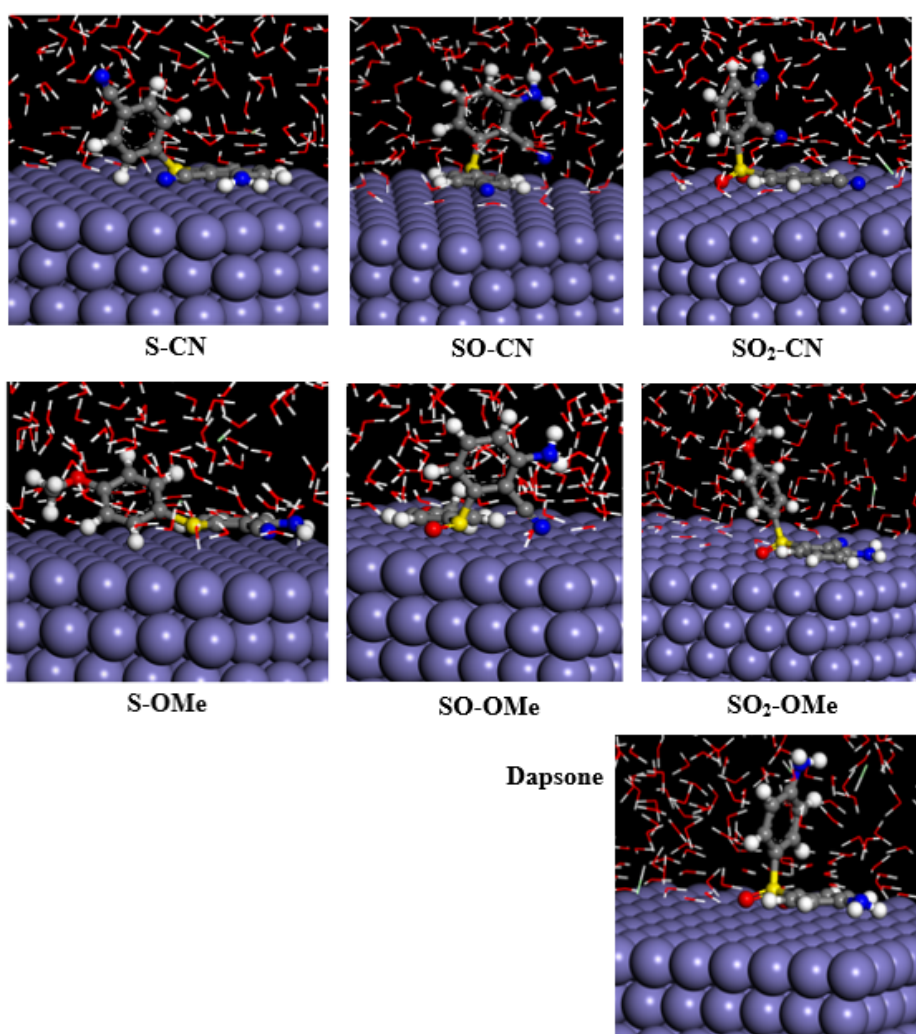
Figure 3. Side views of the most stable configurations of the adsorbed inhibitors on Fe(110) surface in acidic medium (1 M HCl).